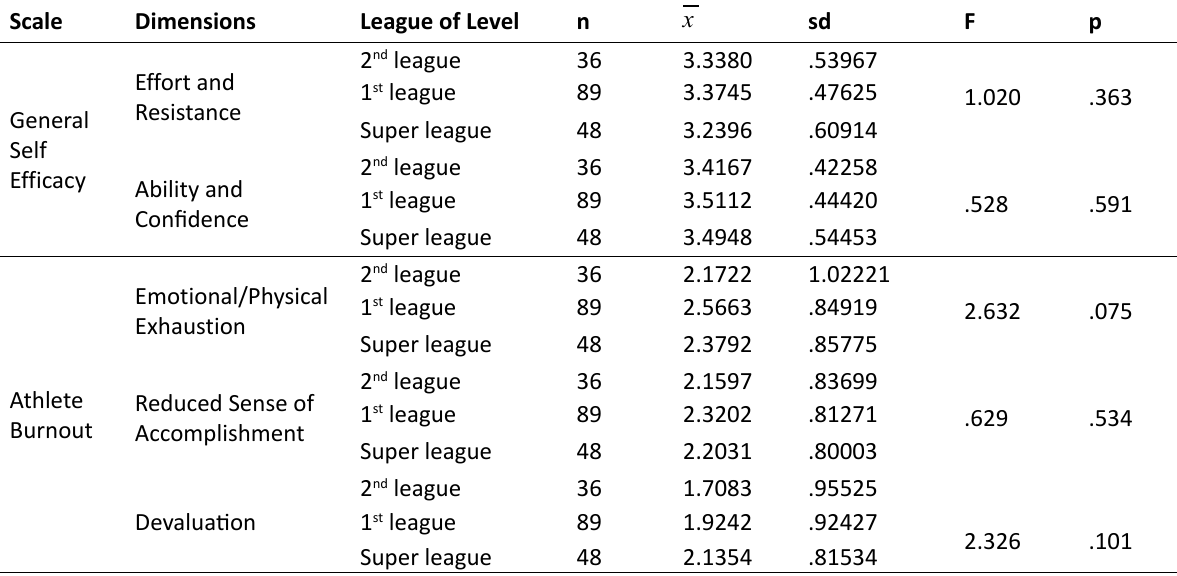
Table 5. Evaluation of general self-efficacy and athlete burnout level by league of level Scale